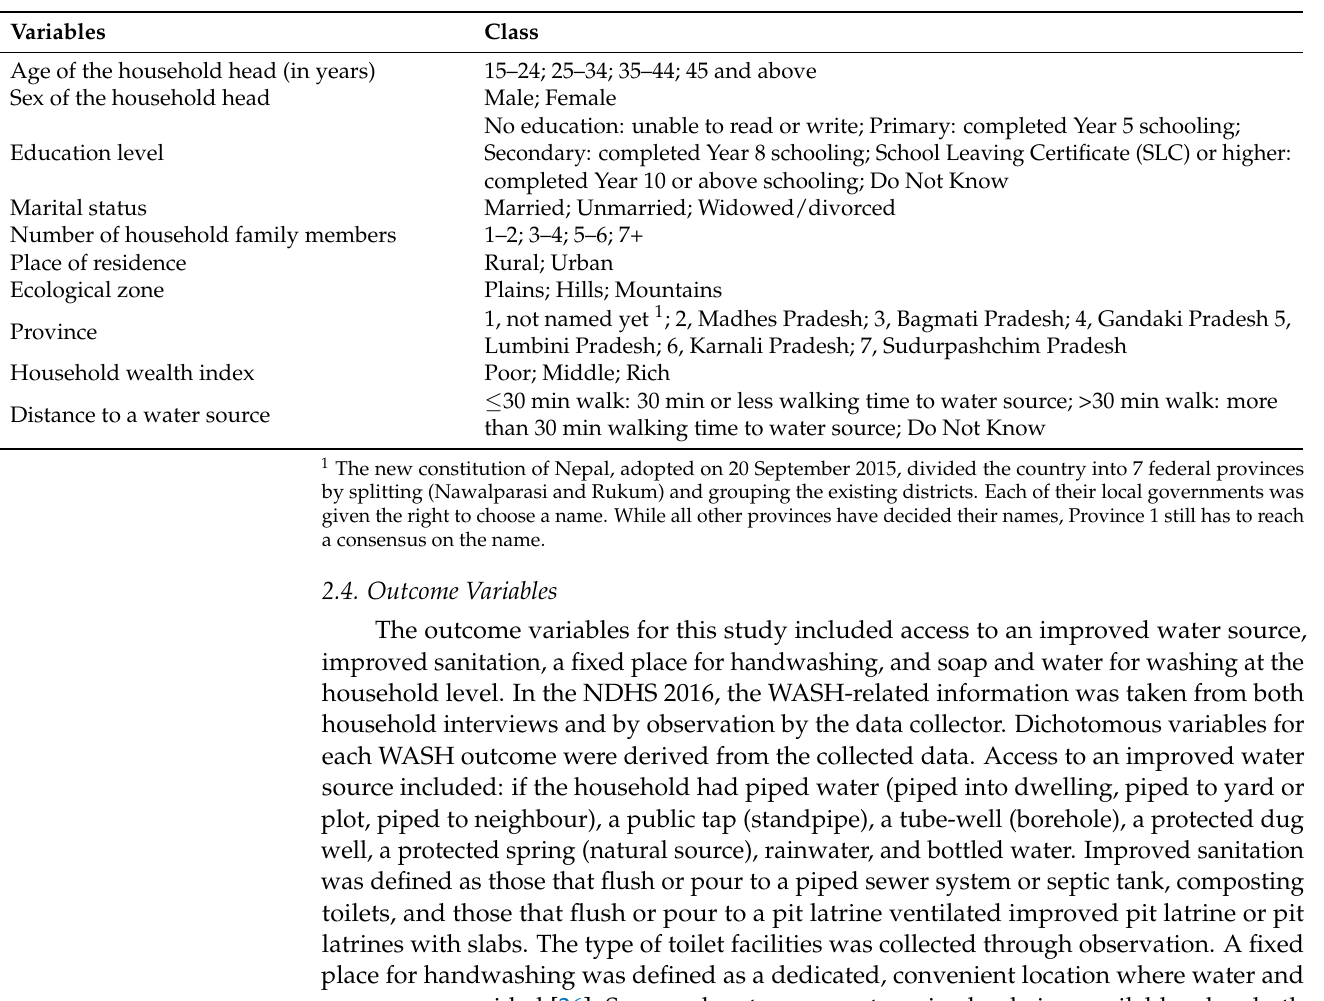
Table 1. Predictor variables included in the